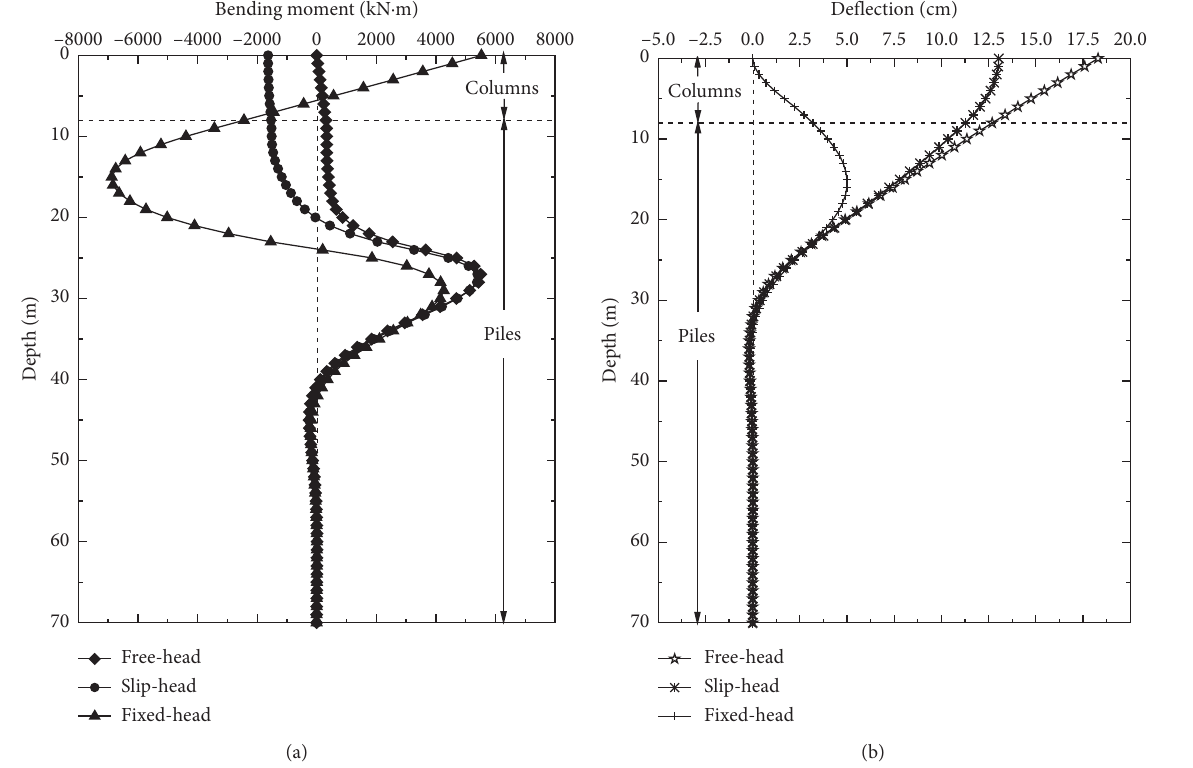
Figure 13: Effect of boundary conditions on the piles-columns response. (a) Bending moment. (b)